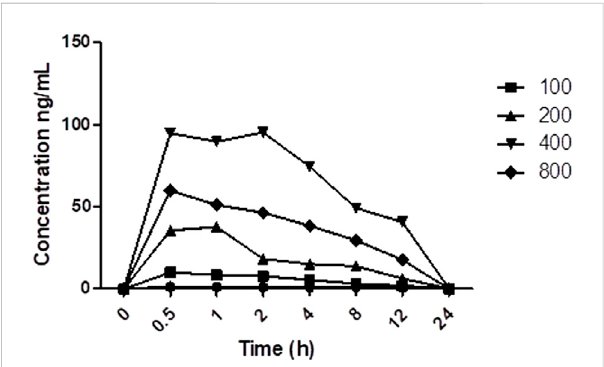
FIGURE 5 Area under plasma TAC concentration vs. time pro fi le (different doses of PRE).